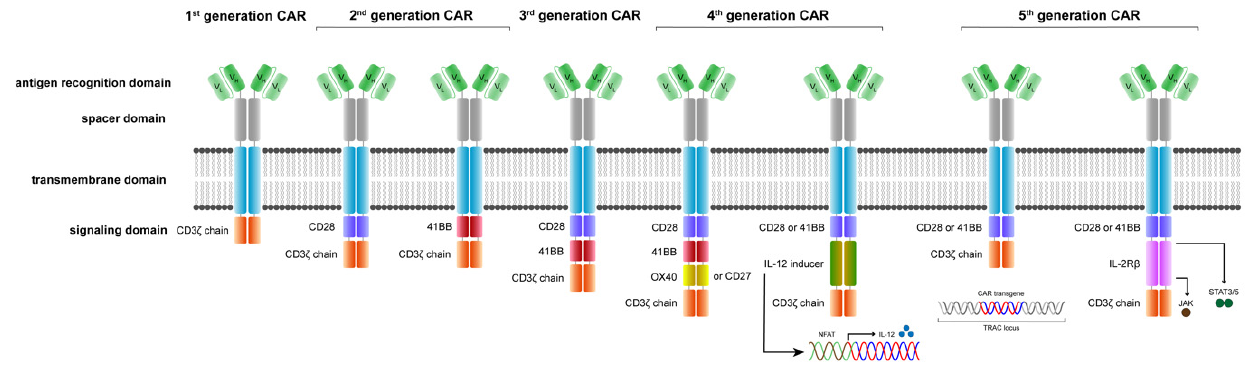
Figure 2. Evolution of CAR receptors.